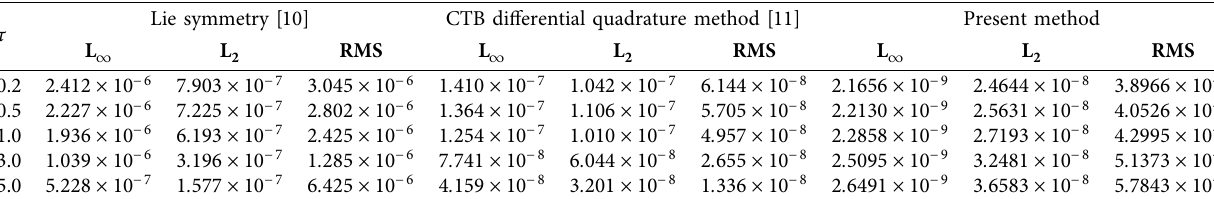
Figure 6: (a) Absolute error at k � 4, M � 5 and (b) absolute error at k � 2, M � 3 of Example 2. Table 2: Comparison of L , L , and RMS error norms of present method with [10, 11] for Example 2 at diferent τ and fxed δ � 0 . 5. ∞ 2